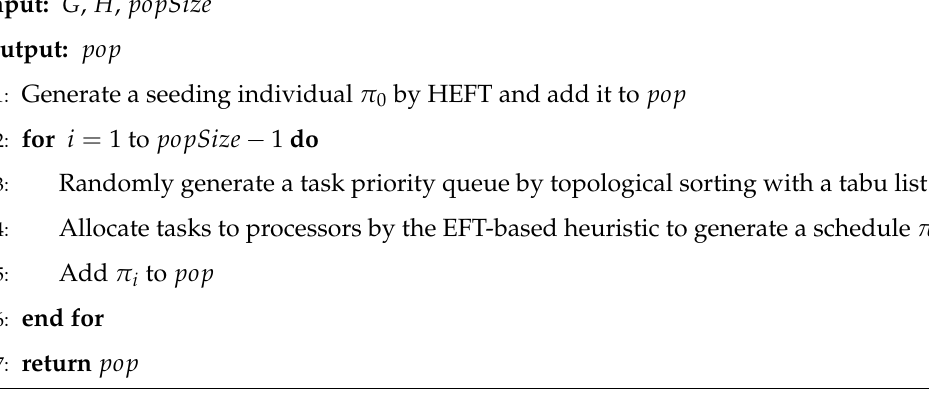
Algorithm 1. Population